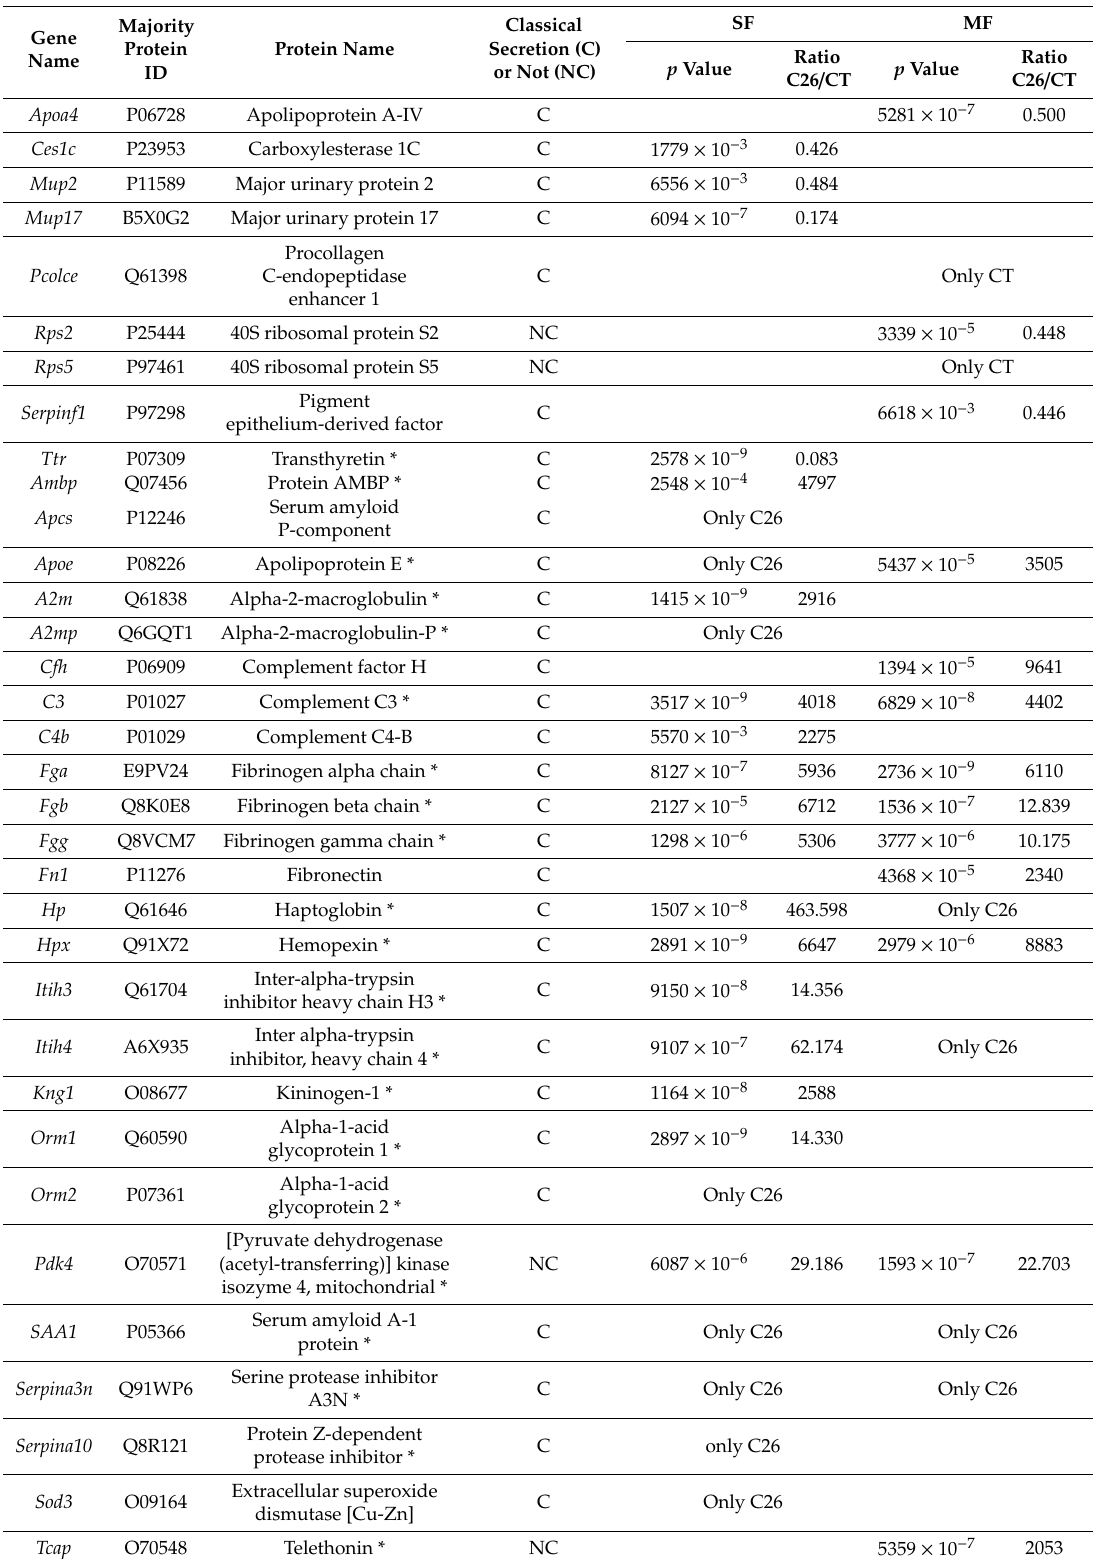
Table 2. List of proteins dysregulated and potentially secreted by the skeletal muscle of C26 mice. ( A ) Proteins the most downregulated. ( B ) Proteins the most